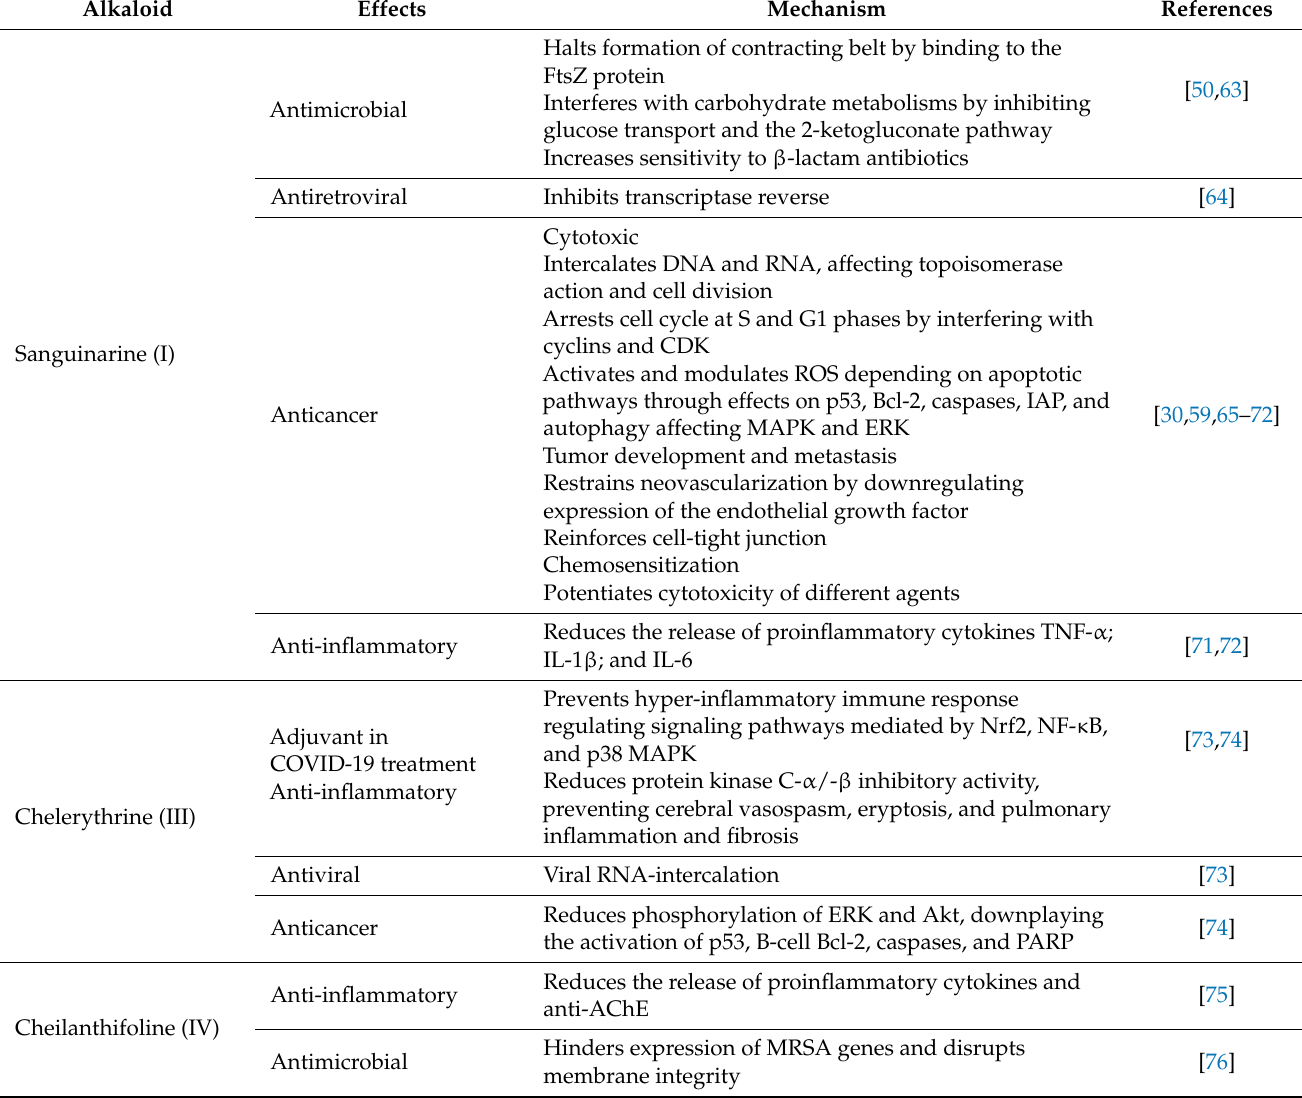
Table 3. Pharmacological effects of sanguinarine and related